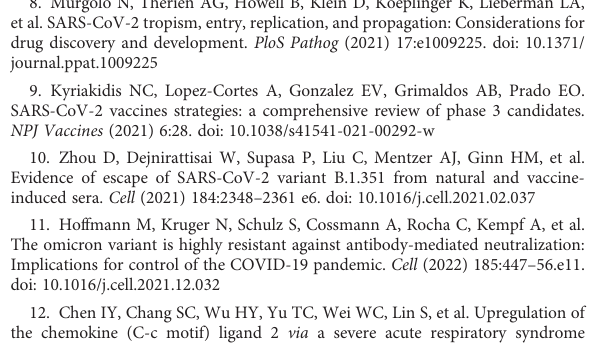
List of GO enrichment terms of RNA transcripts detected from control, mock and spike-transfected THP1 cells.